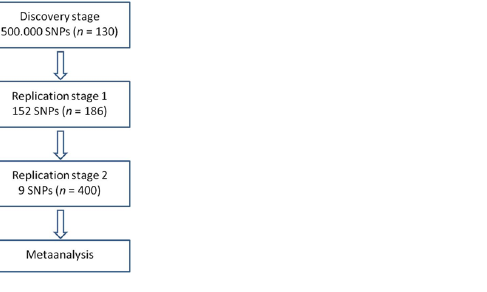
Figure 1. Study design illustrating the genome-wide associa- tion (GWA) study